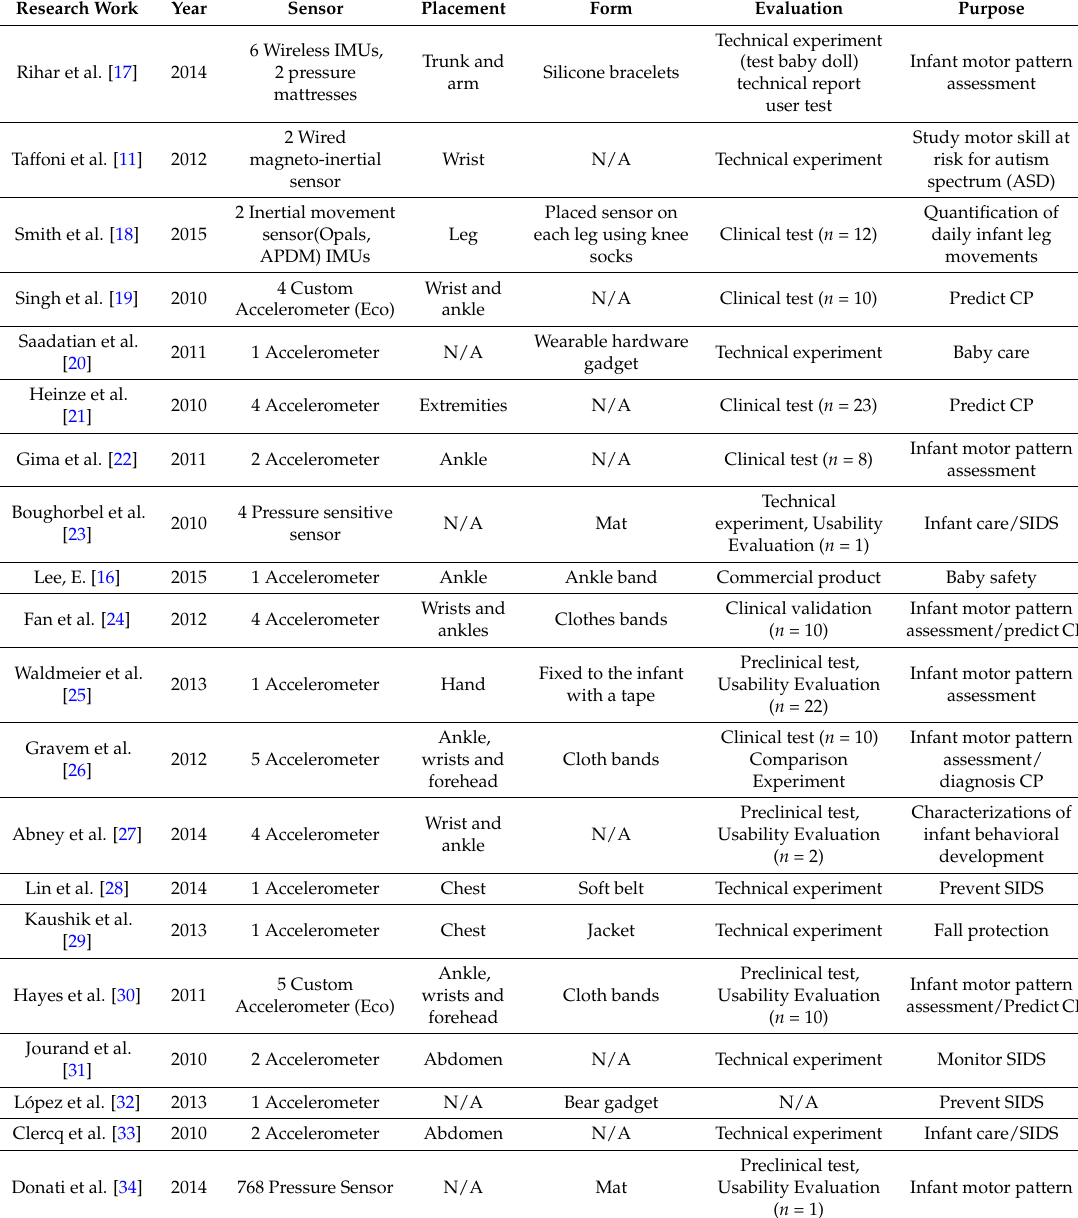
Table 2. Overview of the wearable sensor system to monitor infant